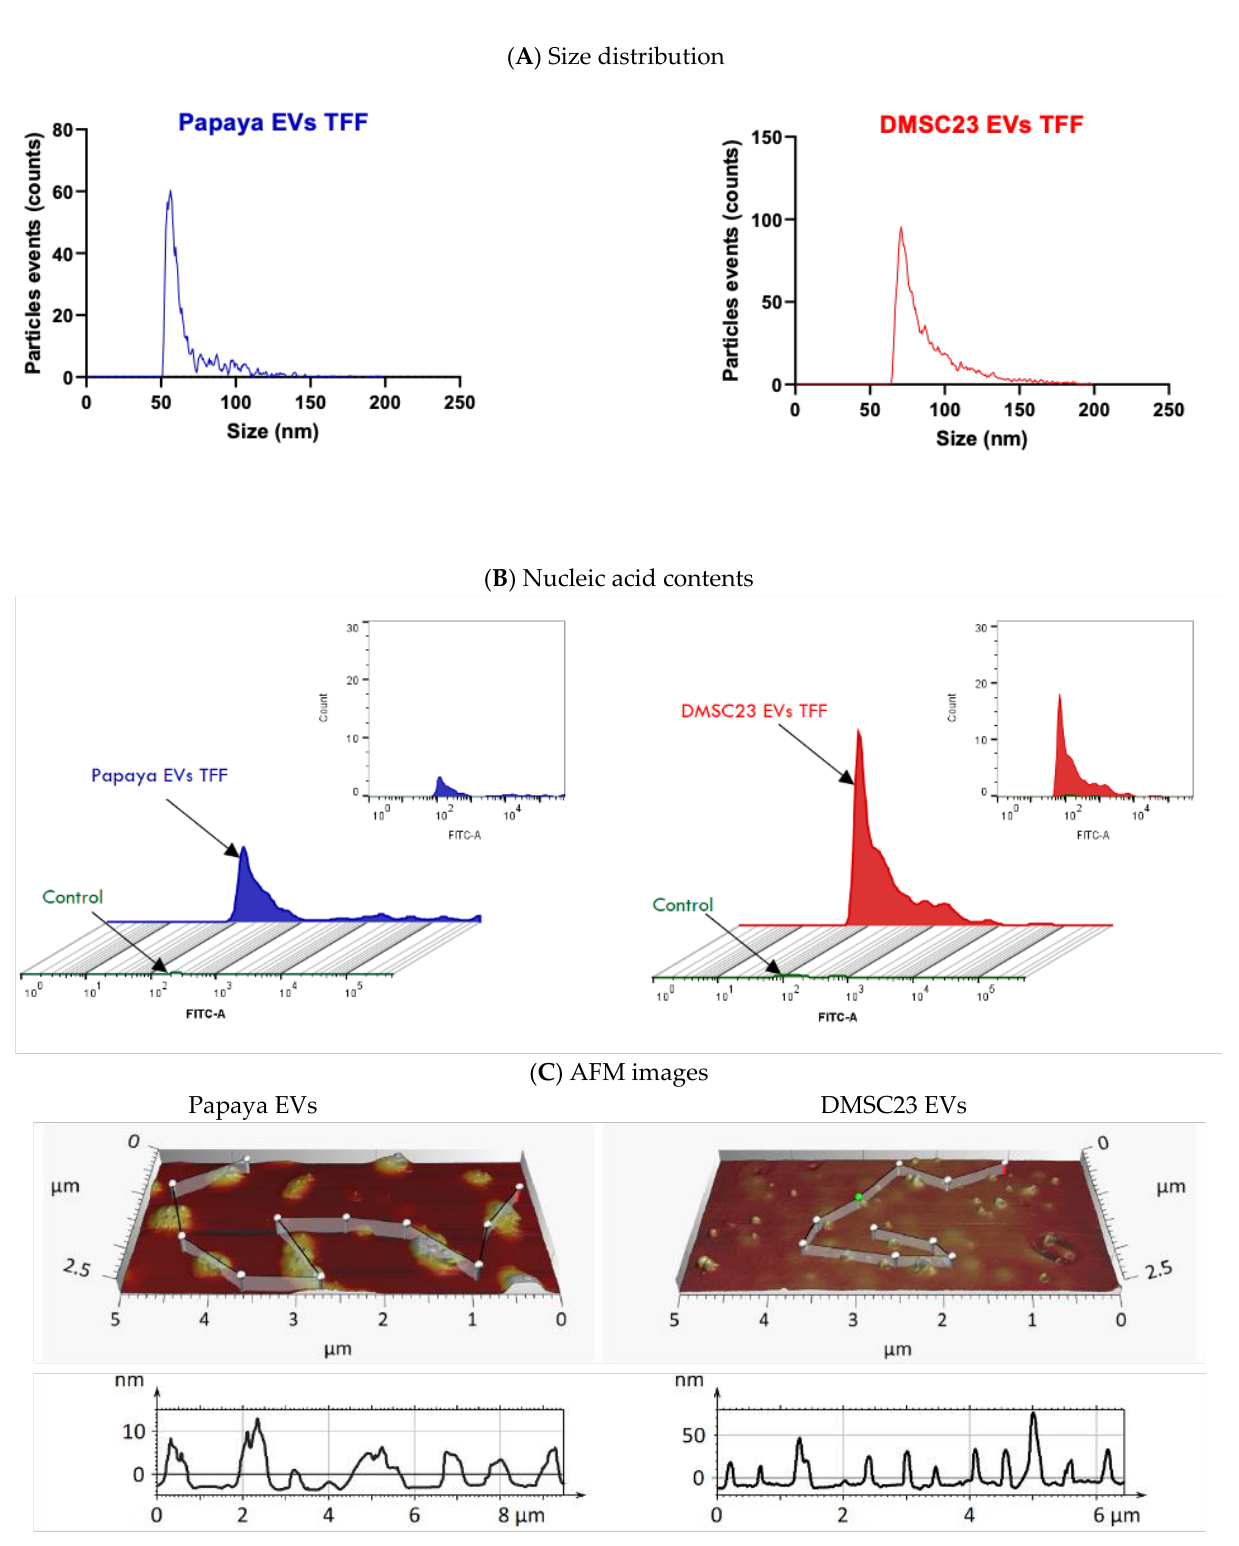
Figure 1. PEVs and DEVs characterization. ( A ) Size and size distribution–Nano FCM. ( B ) Composition of nucleic acid— Nano FCM. ( C ) Size and morphology of PEVs and DEVs—AFM.